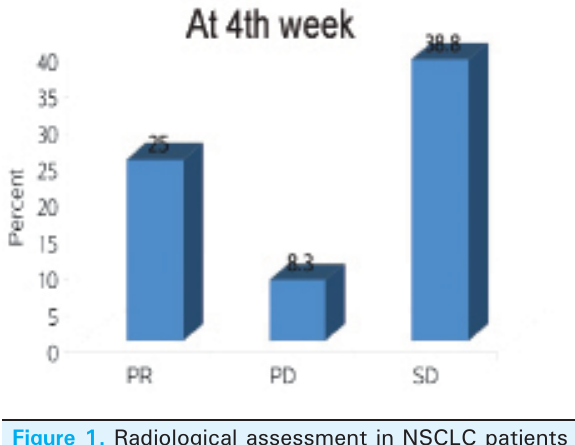
Figure 1. Radiological assessment in NSCLC patients treated with ge fi tinib at 4th week